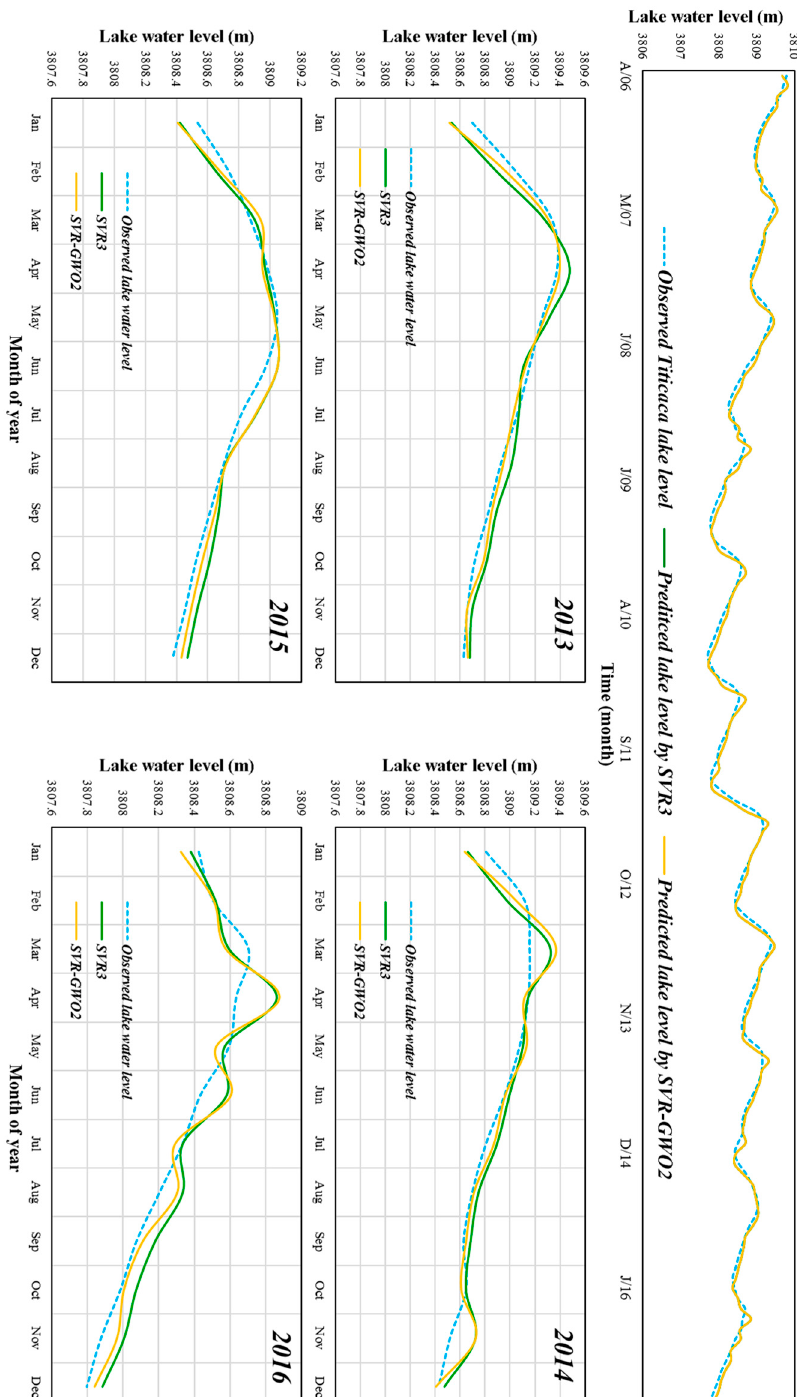
Figure 10. Time series plot of observed and predicted LWL for the best SVR and SVR-GWO models for four years of 2013, 2014, 2015 and 2016.